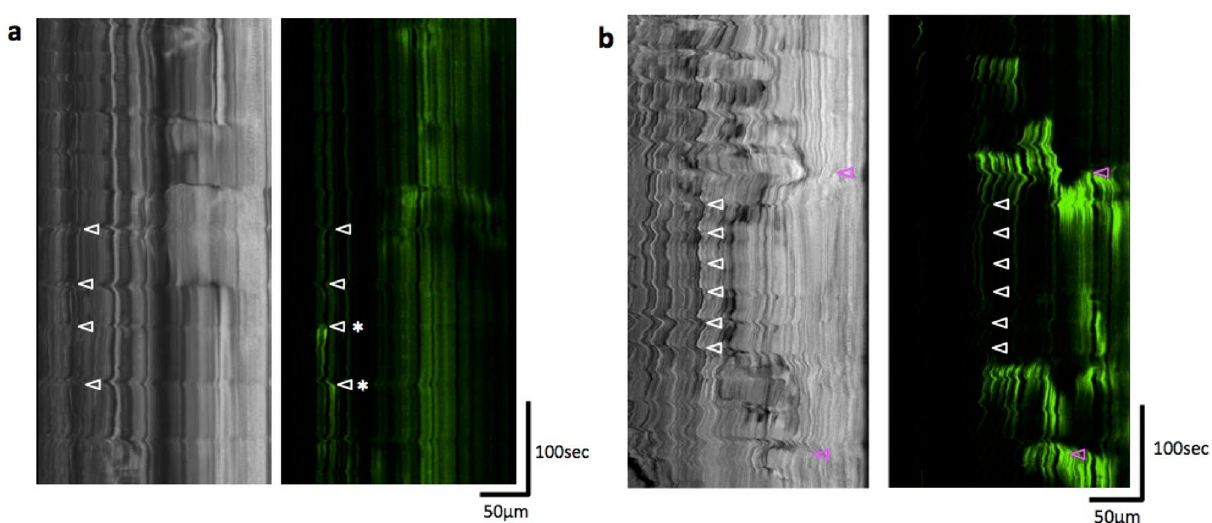
Figure 5. Regular movements observed in the distal intestine at 4 and 7 dpf and peristaltic reflex-like activity observed at 7 dpf without feeding. Kymgraphs of the bright field and GCaMP3 fluorescence movies, at 4 dpf ( a ) and 7 dpf ( b ). Regular movements (white triangles) were not always associated with Ca 2+ events in the circular smooth muscles, although weak Ca 2+ events could be sometimes associated with the regular movements, as indicated by asterisks in ( a ). On the other hand, peristaltic reflex-like movement (magenta triangles) which was sometimes observed without feeding was associated with strong Ca 2+ events in the circular smooth